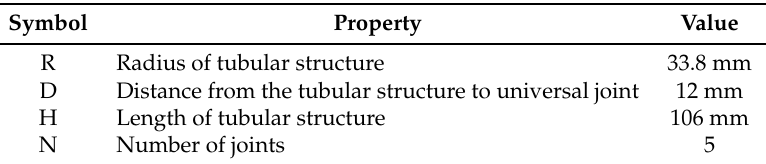
Figure 6. The real designed CDHRM system and its working space. Table 1. The parameters of the CDHRM system.